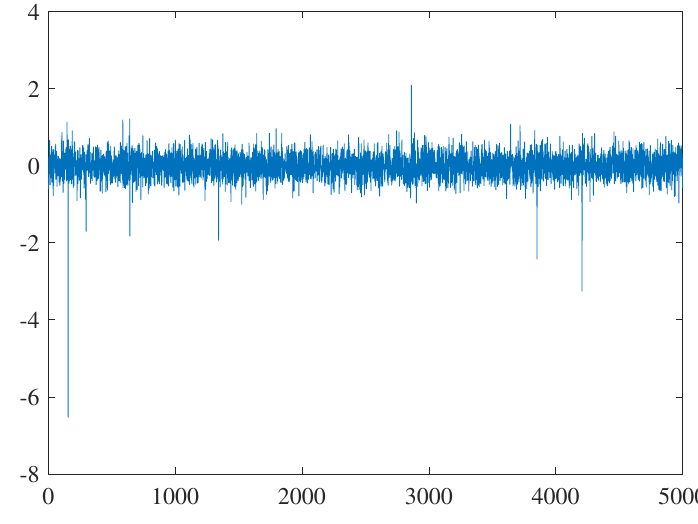
Figure 9. Noise signal in simulation